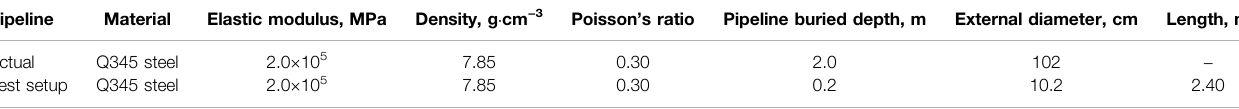
TABLE 2 | Speci fi c parameters of the pipeline and physical analog model.